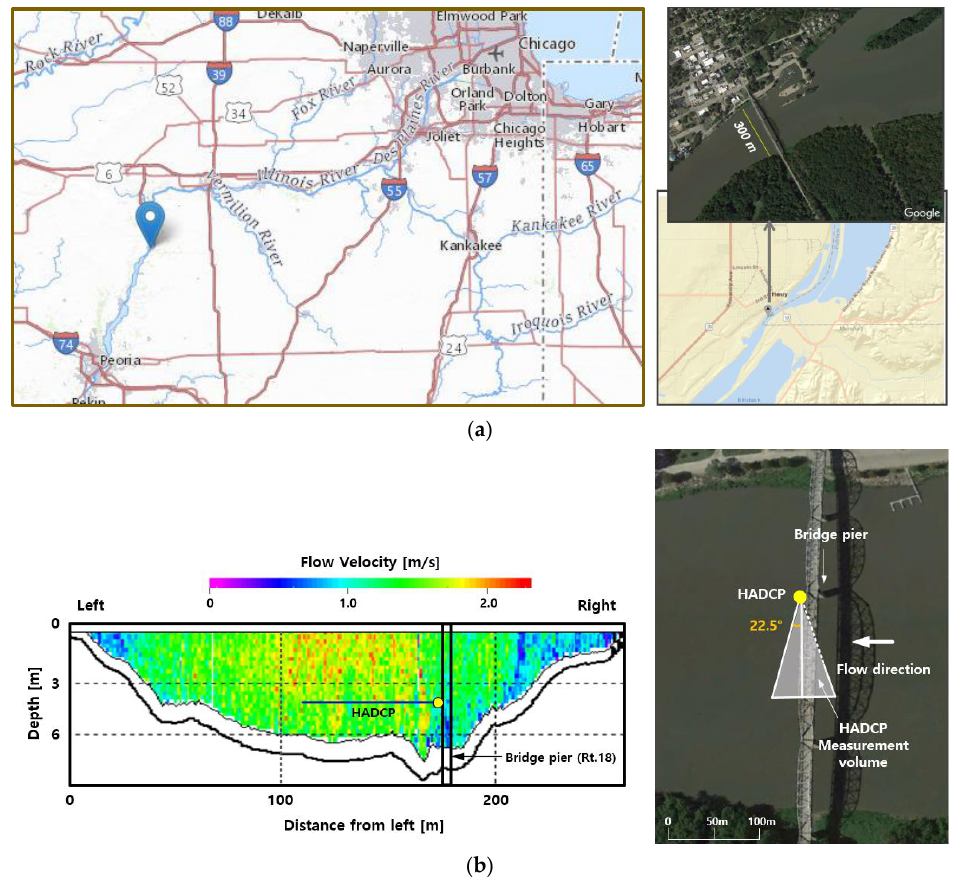
Figure 2. USGS gaging station #05558300 on Illinois River, at Henry (IL): ( a ) gaging site location; and ( b ) position of the HADCP in the measurement cross-section (the ADCP measurement was taken to an extreme flow event). Table 1. IVRC regression equations (source: https://waterdata.usgs.gov/monitoring-loca-